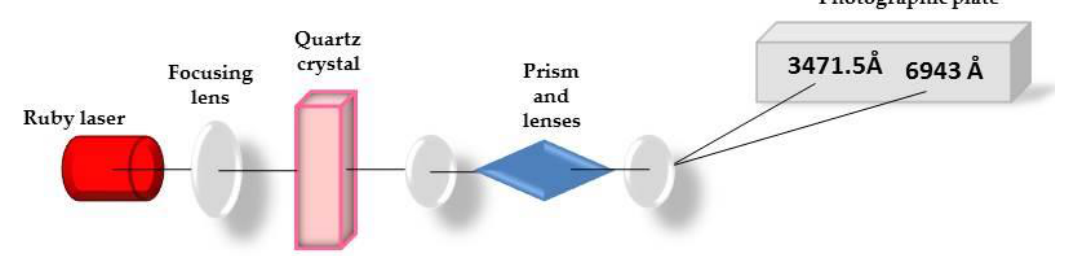
Figure 1. First observation of the second harmonic generation .